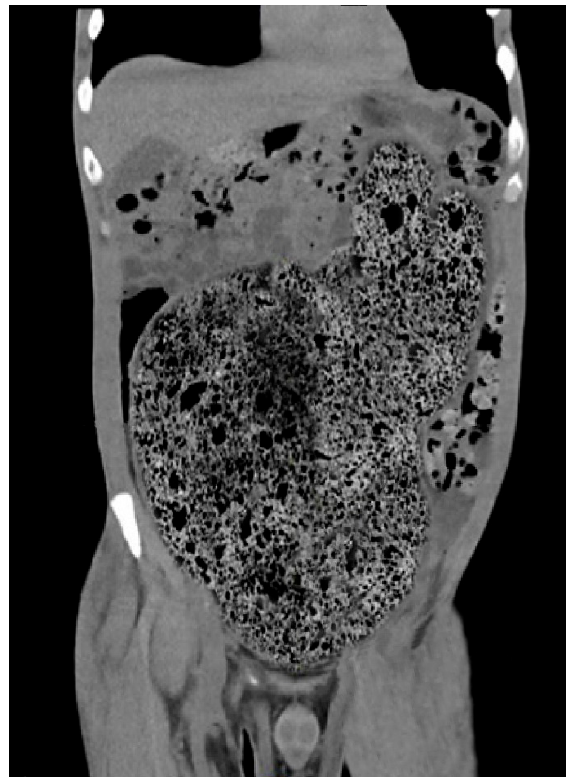
Figure 7. CT scan with idiopathic megarectum and megacolon.